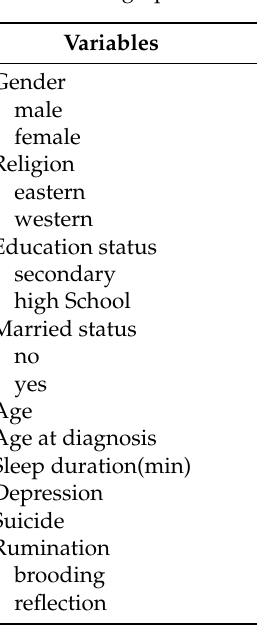
Table 1. Demographic and key variables of participants ( N =